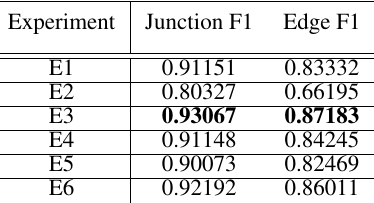
Table 3. F1 score of experiments with different loss factor setups, see Table 1. Case E3 performed best, where we used a higher factor λ junc in the training phases.